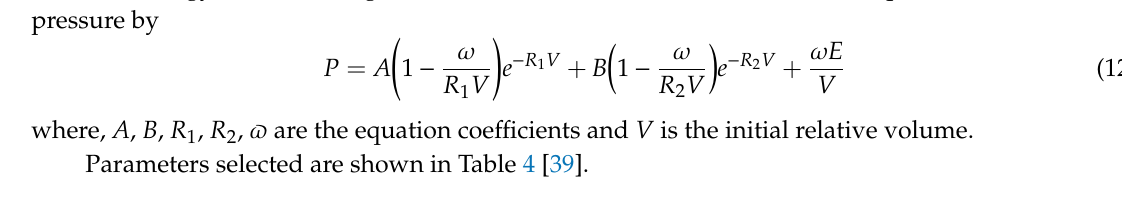
Table 4. Parameters of TNT